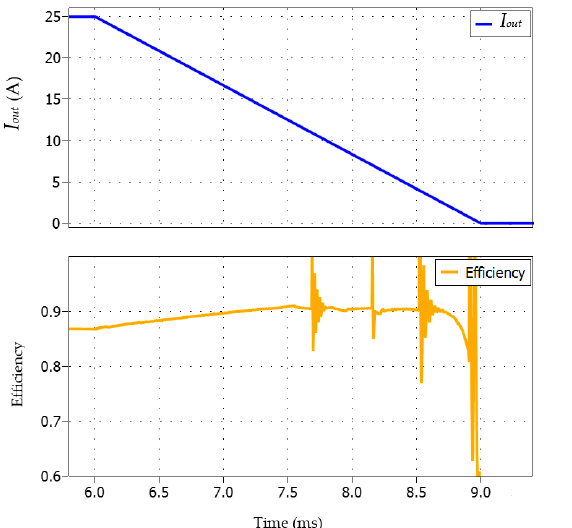
Figure 10. Simulation of the multiphase converter power efficiency: ( a ) N -phase converter with phase shedding disabled, cases with N ranging from 1 to 5; ( b ) converter global efficiency during a load current increase with phase shedding enabled; ( c ) converter global efficiency during a load current decrease without phase shedding enabled.